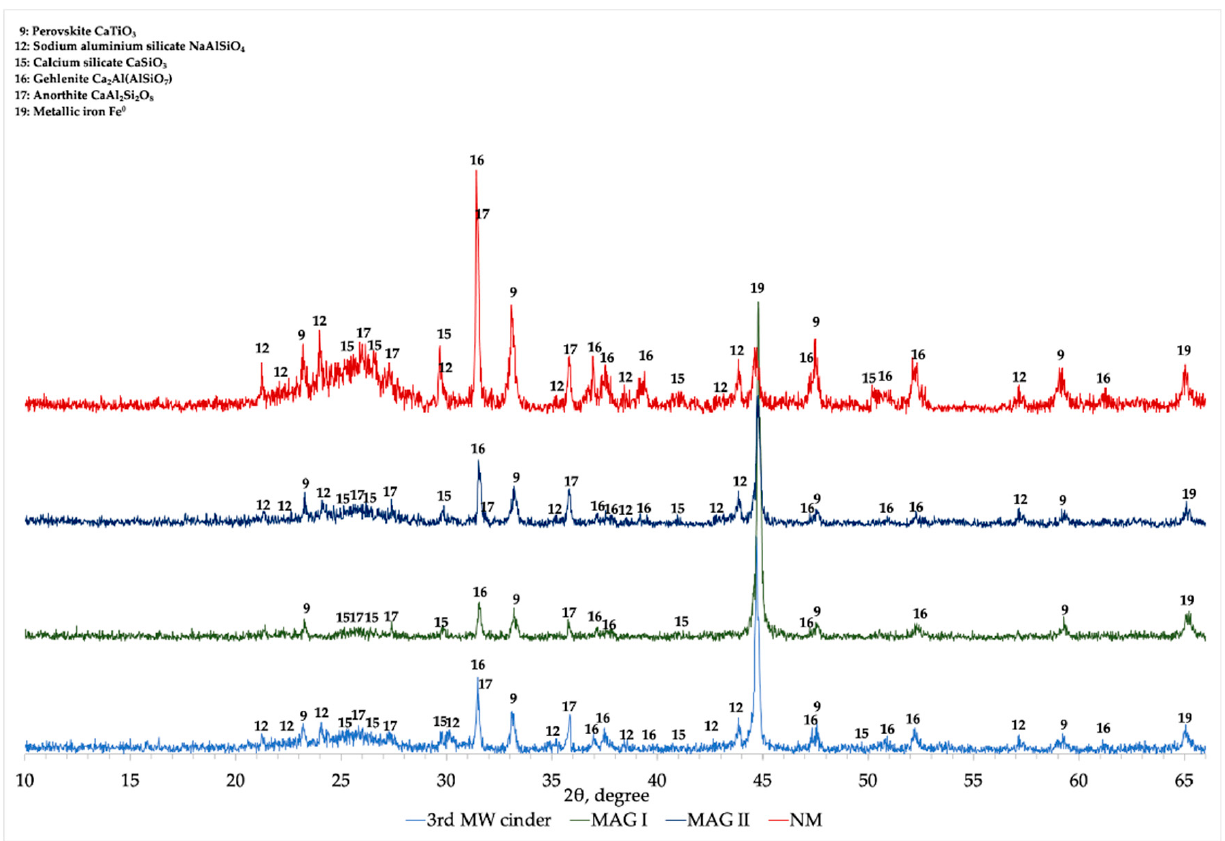
Figure 12. Comparison of the XRD profile of cinder after 3rd MW roasting process, magnetic fraction (MAG I), weak magnetic fraction (MAG II) and non-magnetic fraction (NM).